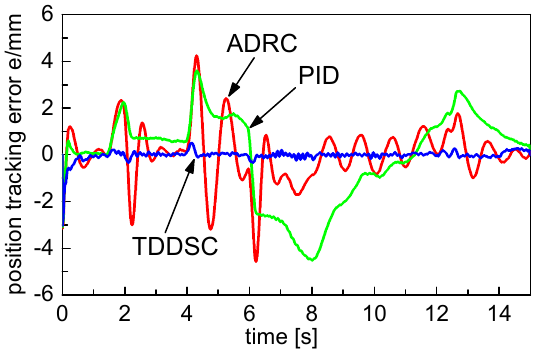
Figure 14. Displacement tracking error as a function of time under varying supply pressure.